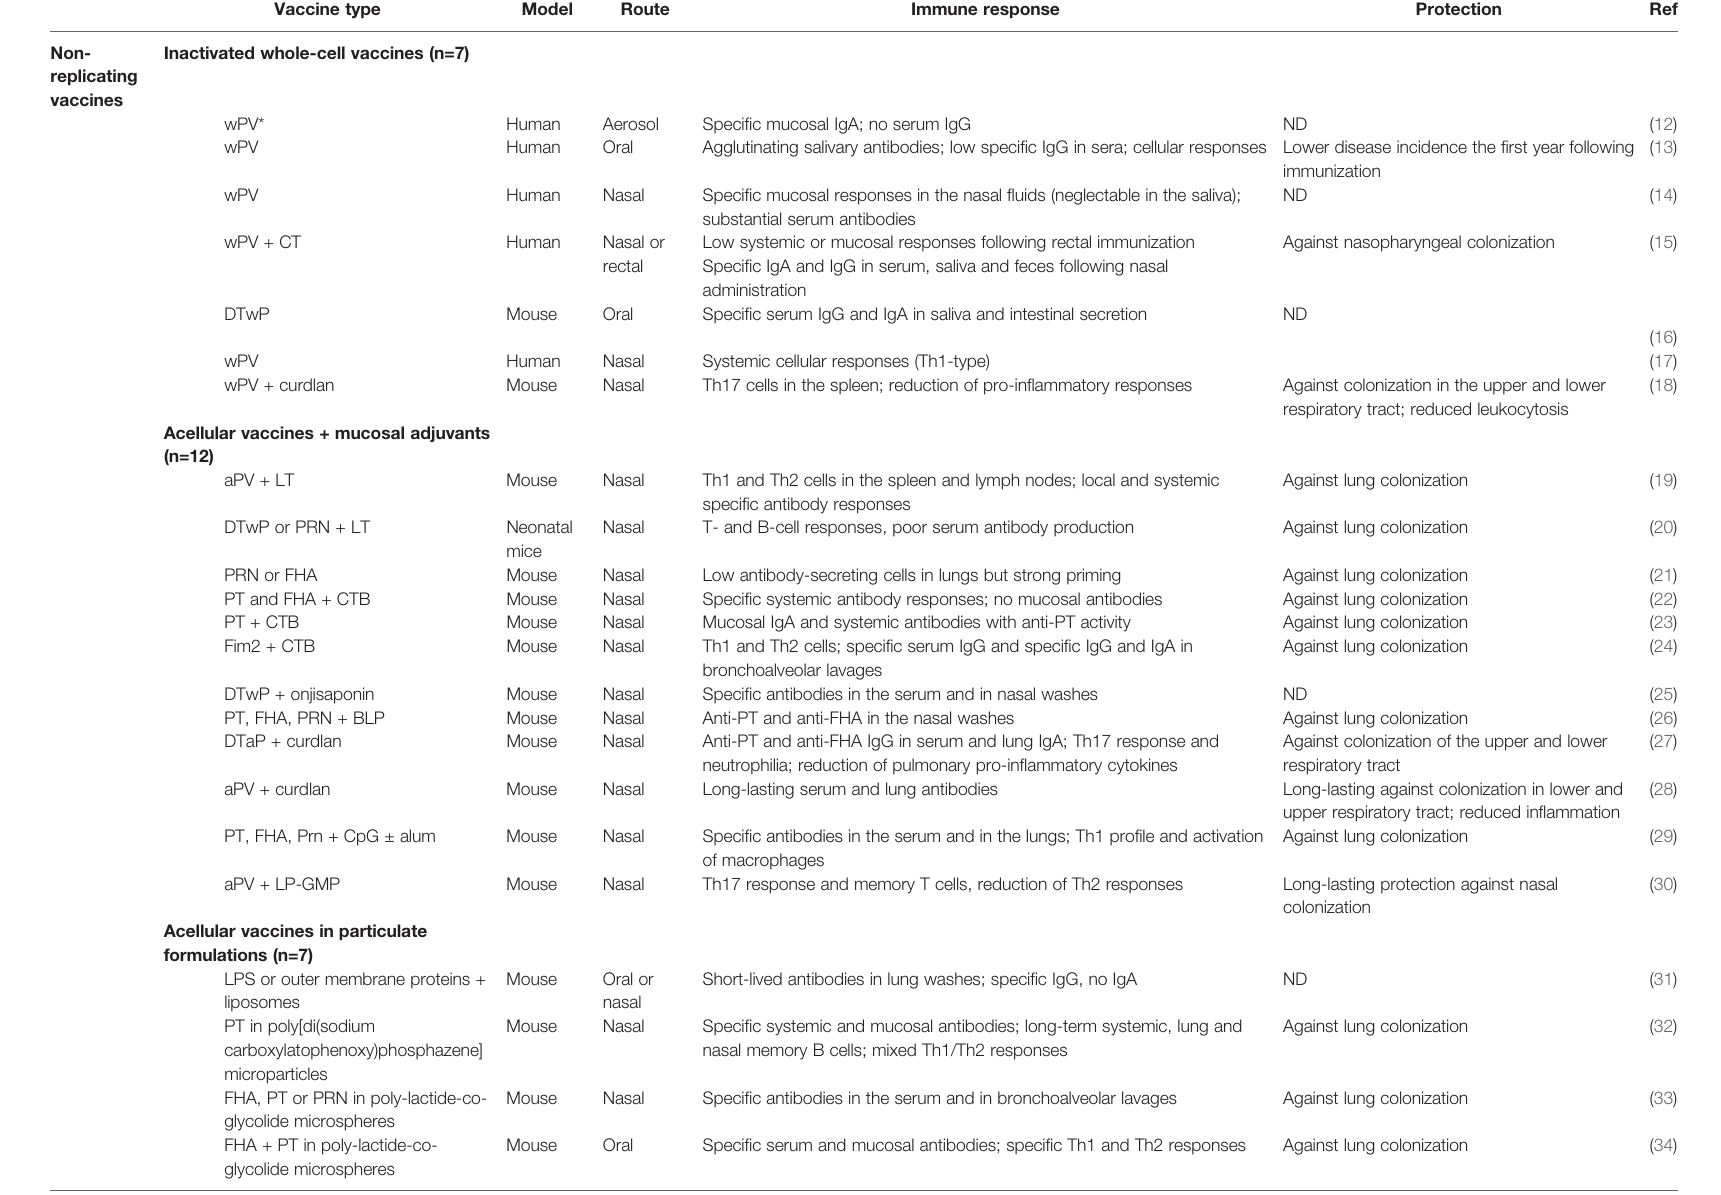
TABLE 1 | Main characteristics of mucosal vaccines against